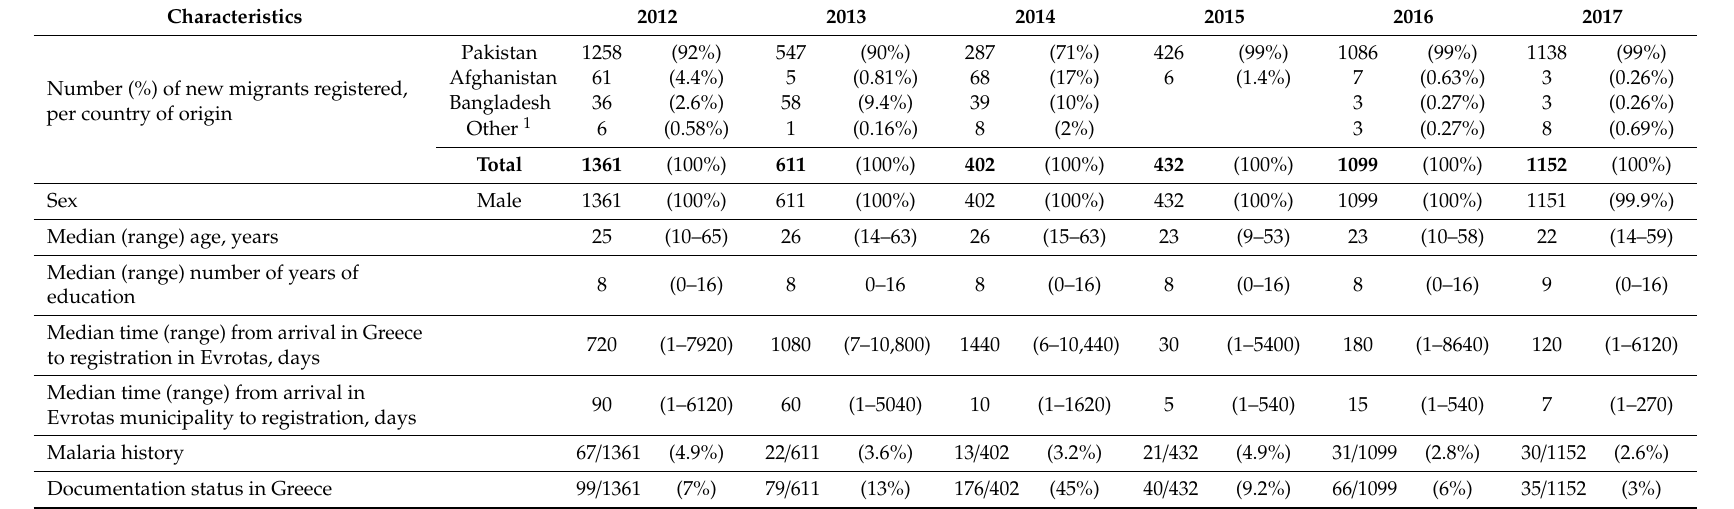
Table 1. Characteristics of the population covered by malaria Pro-Active Case Detection program, Evrotas Municipality, 2012–2017.